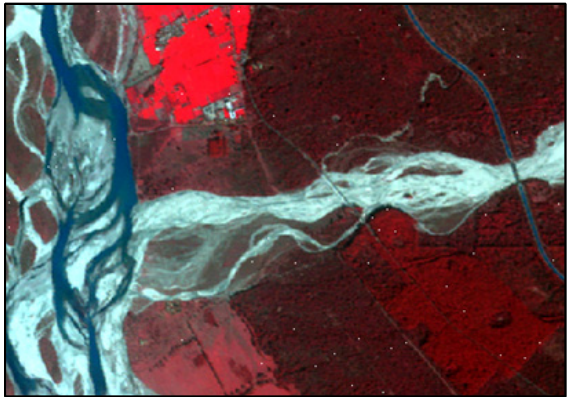
Figure 20. Formosat-2 image corrupted with noise.